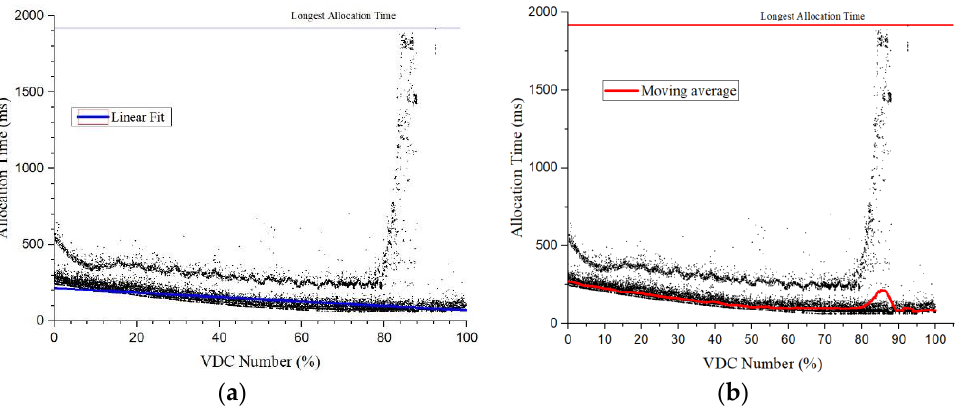
Figure 11. VDC Allocation time. (a) Linear Fitting process on VDC allocations time; (b) Moving Average process on VDC allocations time